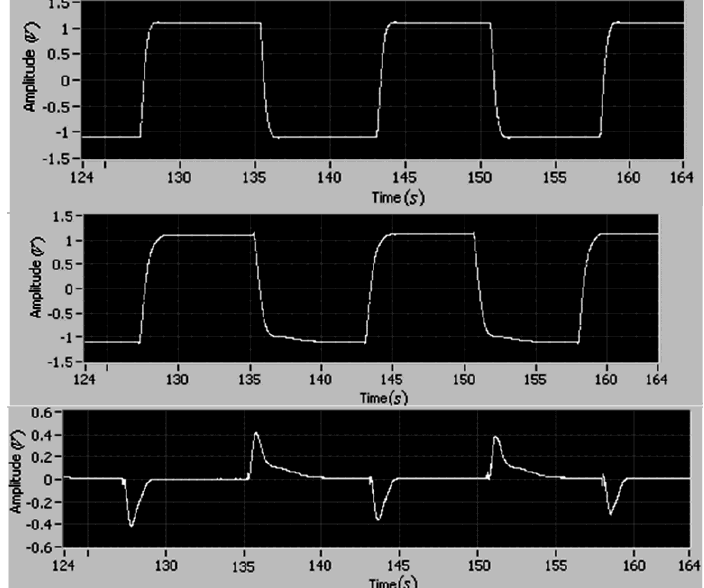
(middle) and (bottom ), respectively).